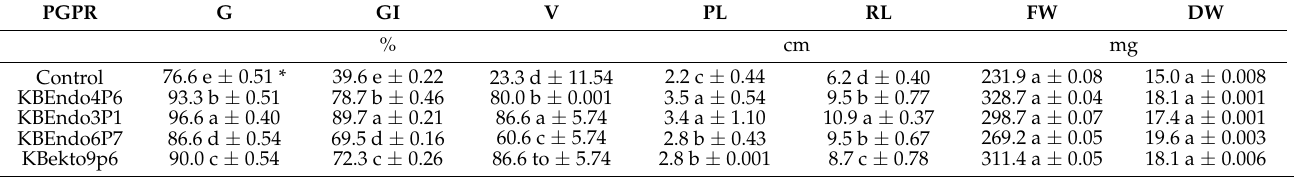
Table 1. Effect of rhizobacteria on the germination percentage (G), germination index (GI), vigor